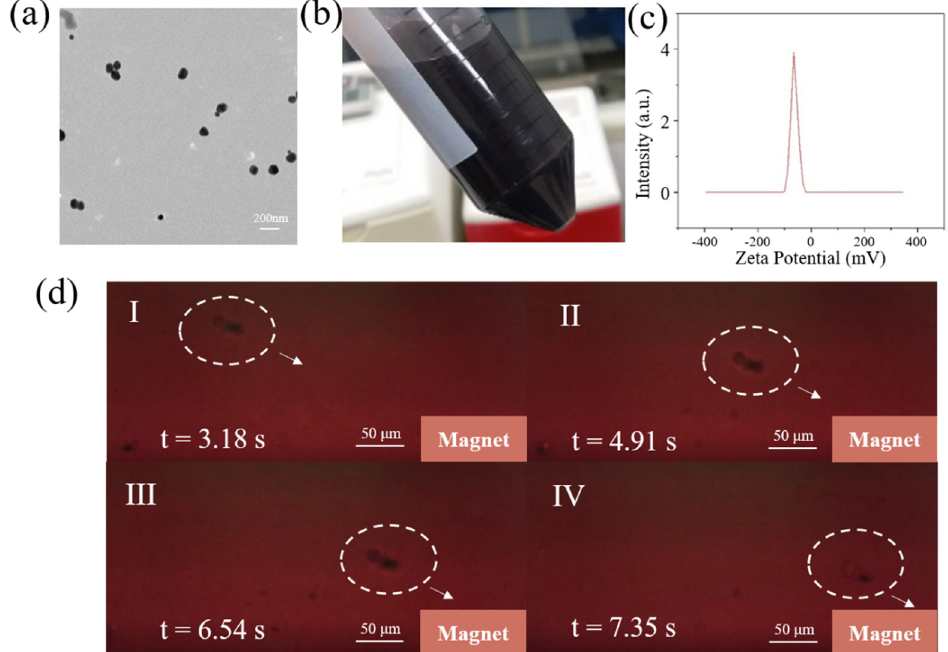
Figure 3. ( a ) The TEM of immunomagnetic beads; ( b ) the solution containing prepared immunomagnetic beads; ( c ) the zeta potential of the beads was measured as − 63.0 mV; ( d ) the off-chip pre-experiment in the culture dish, demonstrating that the magnetic force between the immunomagnetic beads and the magnet was strong enough to drag cells and cell clusters to migrate directly.